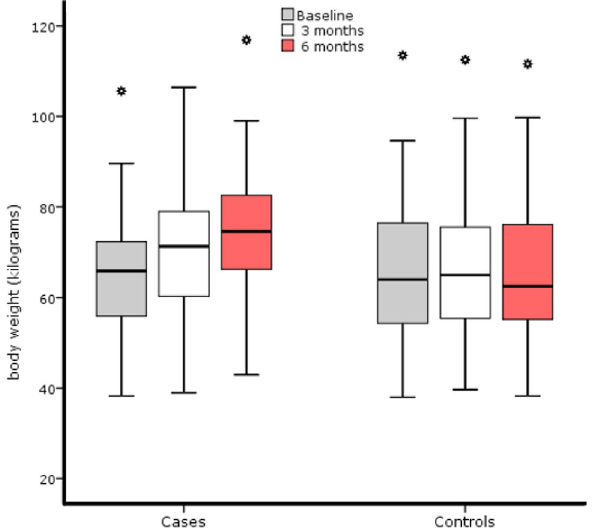
Figure 2. Body weight evolution by study groups.